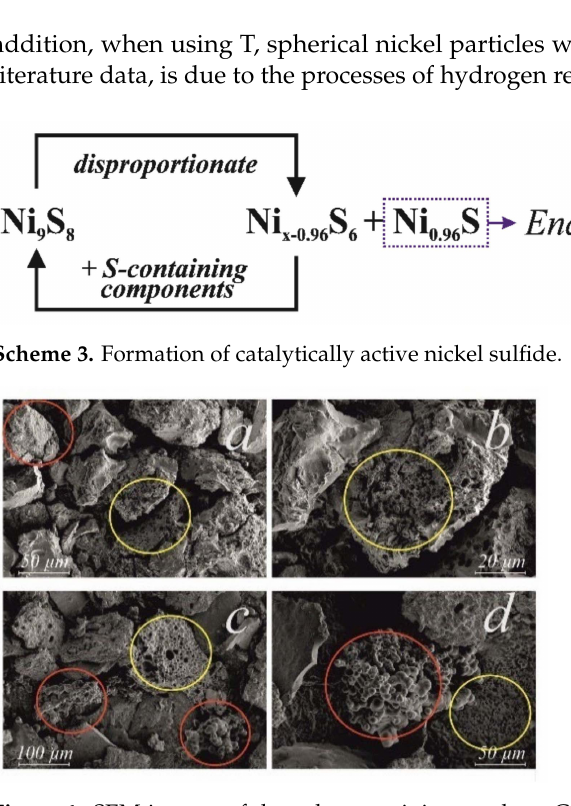
Figure 4. SEM images of the coke-containing catalyst: CA (( a ) 50 µ m and ( b ) 20 µ m) and CA+T